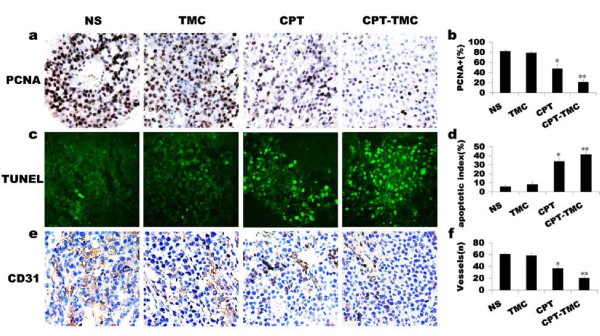
CD31, PCNA and TUNEL analyses for tumor tissue. (a) Tumor sections immunostained with an antibody against PCNA revealed that there were many strongly positive nuclei in control tumor tissues, whereas such nuclei were rare in tumor tissues of CPT-TMC-treated group. (b) Quantification of PCNA staining showed percentage of PCNA-positive nuclei in CPT-TMC-treated group was the lowest among the four groups (*P < 0.05, **P < 0.01). (c) Apoptosis of tumor tissues in different groups were calculated by TUNEL assays, which showed that CPT-TMC induced a significant enhancement of apoptotic cells in contrast to control therapies. (d) Quantification of TUNEL assay shows that apoptosis index of CPT-TMC-treated tumor was much higher than that of control groups (*P < 0.05, **P < 0.01). (e) Tumor sections immunostained with anti-CD31 antibody (brown) for angiogenesis assay. Representative sections were taken from tumor tissue of NS-treated, TMC-treated, CPT-treated and CPT-TMC-treated groups. (f) Histomorphometric assay for tumor microvessels revealed that MVD was significantly lower in CPT-TMC-treated group compared with the controls (*P < 0.05, **P < 0.01).